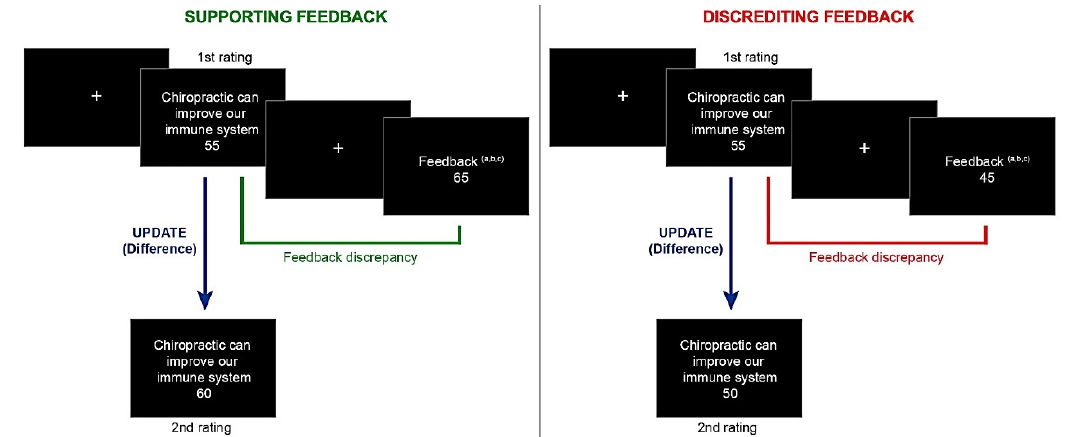
Figure 1. Belief updating task. ( Left ) Example of a supporting (desirable) feedback trial; participants’ initial rating is lower than the feedback received. In each trial, participants had to provide an initial judgement responding to a general question (“How much do you believe the following statement is true from 1 to 100?”). Feedback indices (a,b,c) represent differences in the statements presented depending on the feedback group. (a, Experts) “On average, experts believe that this statement is true from 1 to 100 per cent: ”; (b, Peers) “On average, other participants of the experiment believe that this statement is true from 1 to 100 per cent: ”; (c, Random) “The random number for this trial is: ”. In green, feedback discrepancy represents the difference between the participants’ initial rating and the feedback received. In blue, update (dependent variable) is represented as the difference between the first and second assessments (see Experimental Task section for details). ( Right ) Example of a discrediting (undesirable) feedback trial; participants’ initial rating is higher than the feedback received. In red, feedback discrepancy represents the (discrediting) difference between the participants’ initial rating and the feedback received.